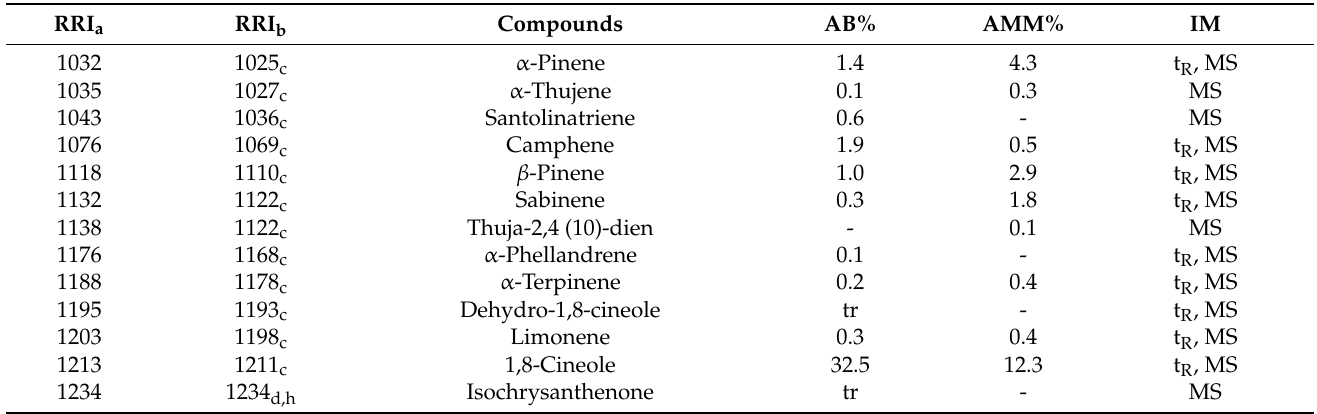
Table 2. The essential oil composition of the aerial parts of A. biebersteinii and A. millefolium subsp. Millefolium